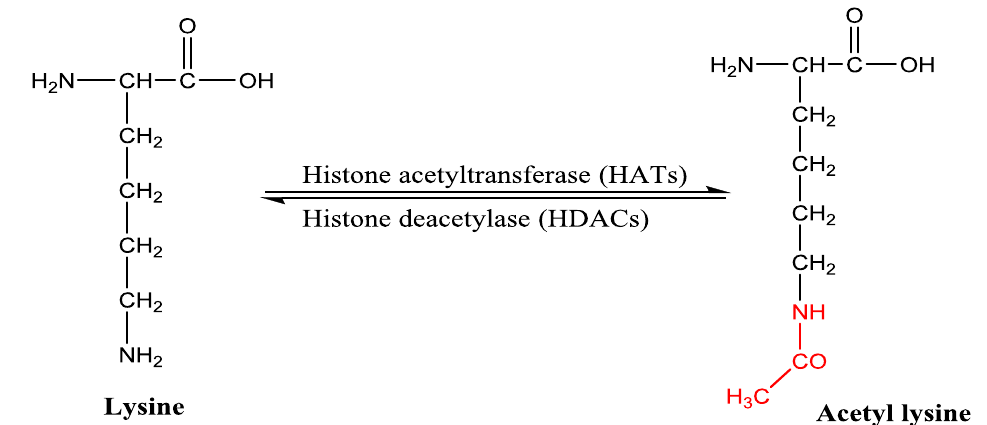
Figure 1. Histone acetylation at the N-terminus lysine by histone acetyltransferases (HATs) and deacetylation by histone deacetylases (HDACs).